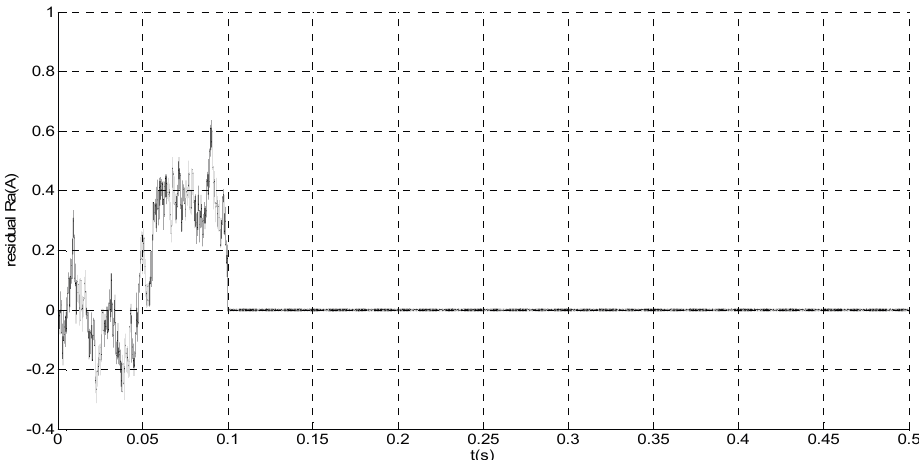
Figure 6. Simulation results of the actual and observation of β axis stator current.